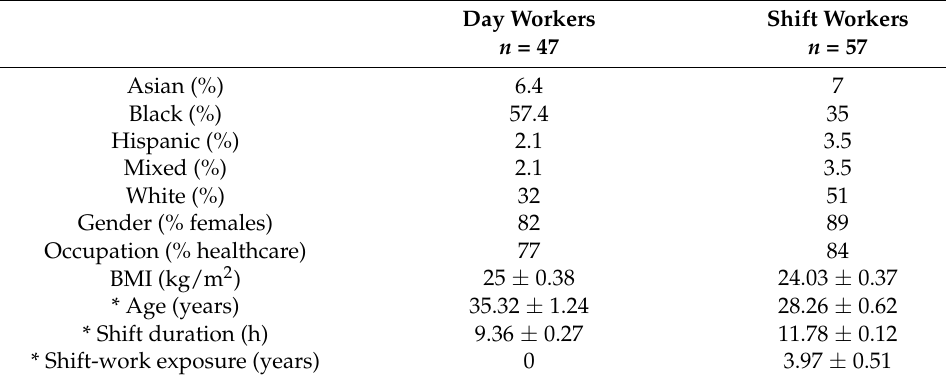
Table 1. Characteristics of the study population.